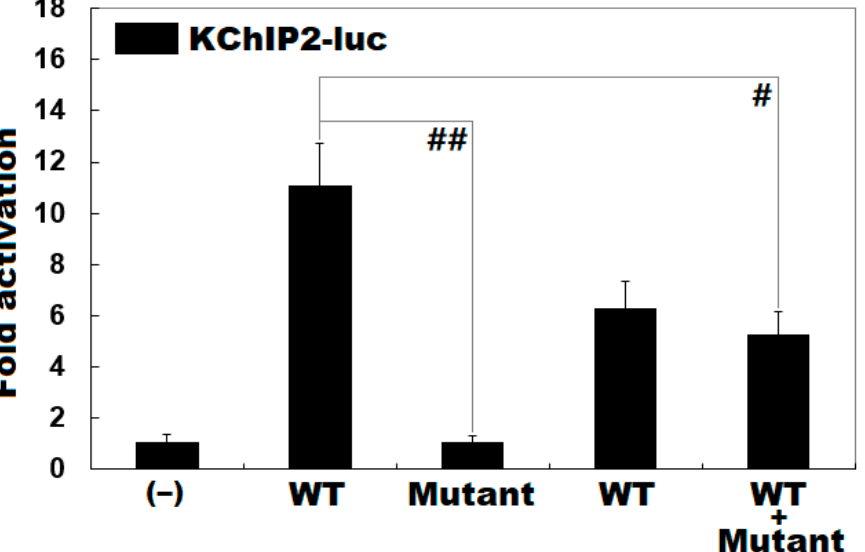
Figure 2. Functional loss of KLF15 caused by the mutation. In cultured HeLa cells, activation of the KChIP2 promoter-driven luciferase by wild-type (WT) or Lys229*-mutant KLF15 (Mutant), alone or in combination, showed that the mutant had no transcriptional activity. Experiments were done in triplicate, and the results are expressed as mean values ± SD. ## and # indicate p < 0.001 and p < 0.01, respectively, compared with the same amount of homozygous WT.